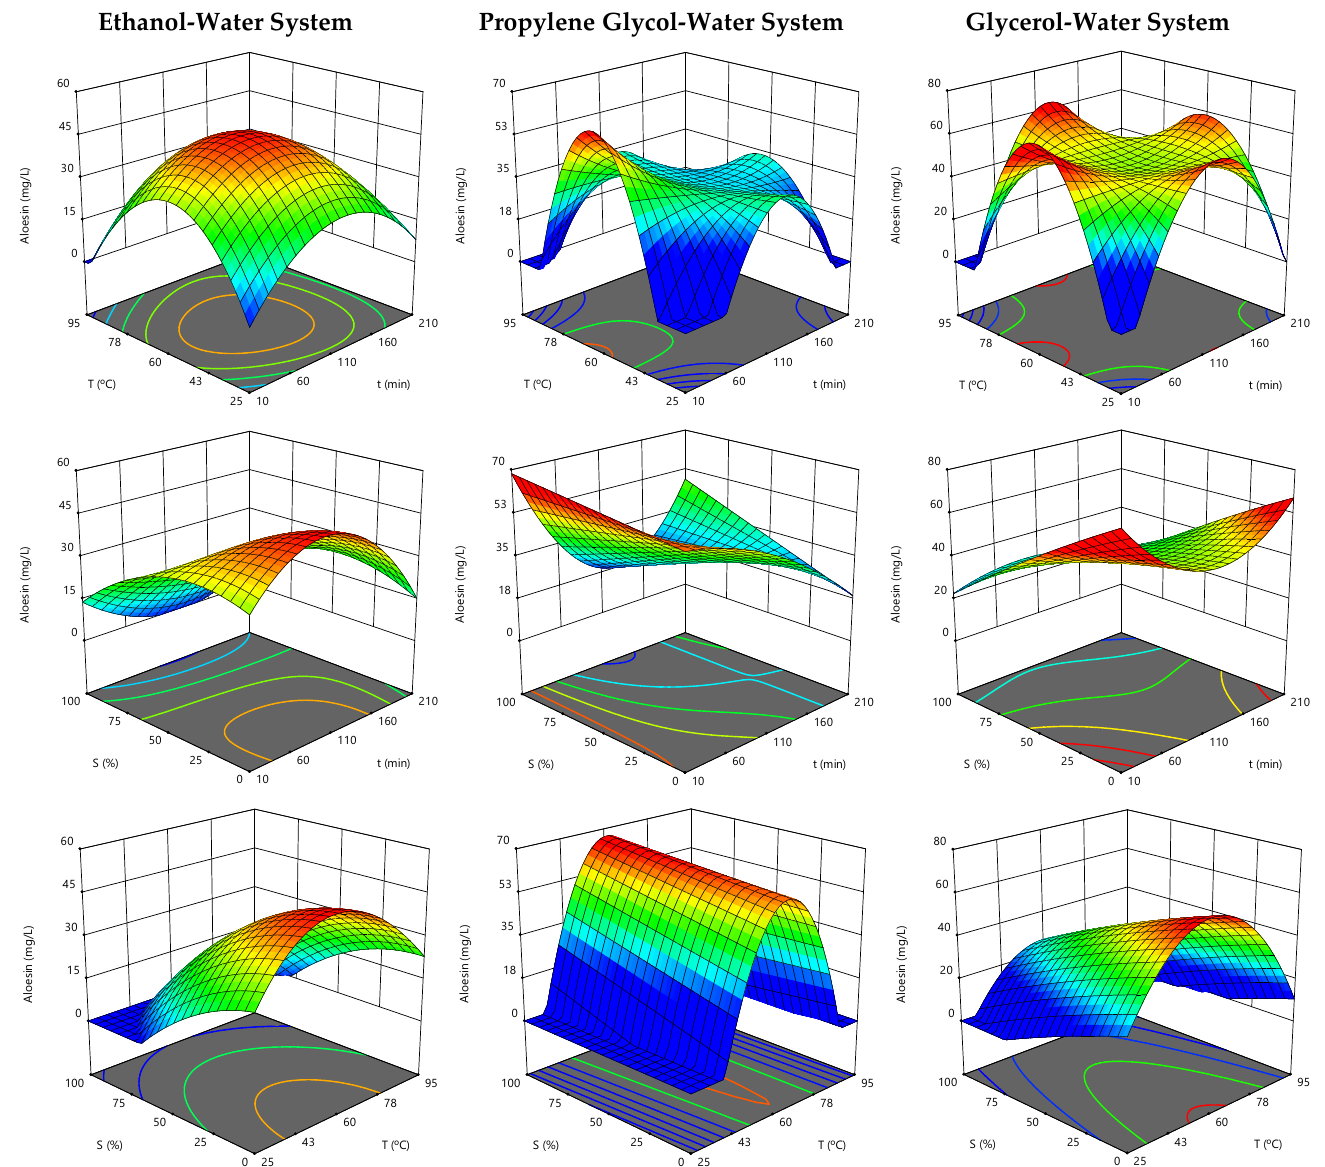
Figure 1. Response surface graphs for the effects of extraction time ( t ), temperature ( T ), and solvent ( S ) on the extraction of aloesin from Aloe vera rind as a function of the alcohol–water system. In each 3D graph, the excluded variable was positioned at its optimal value (Table 2).